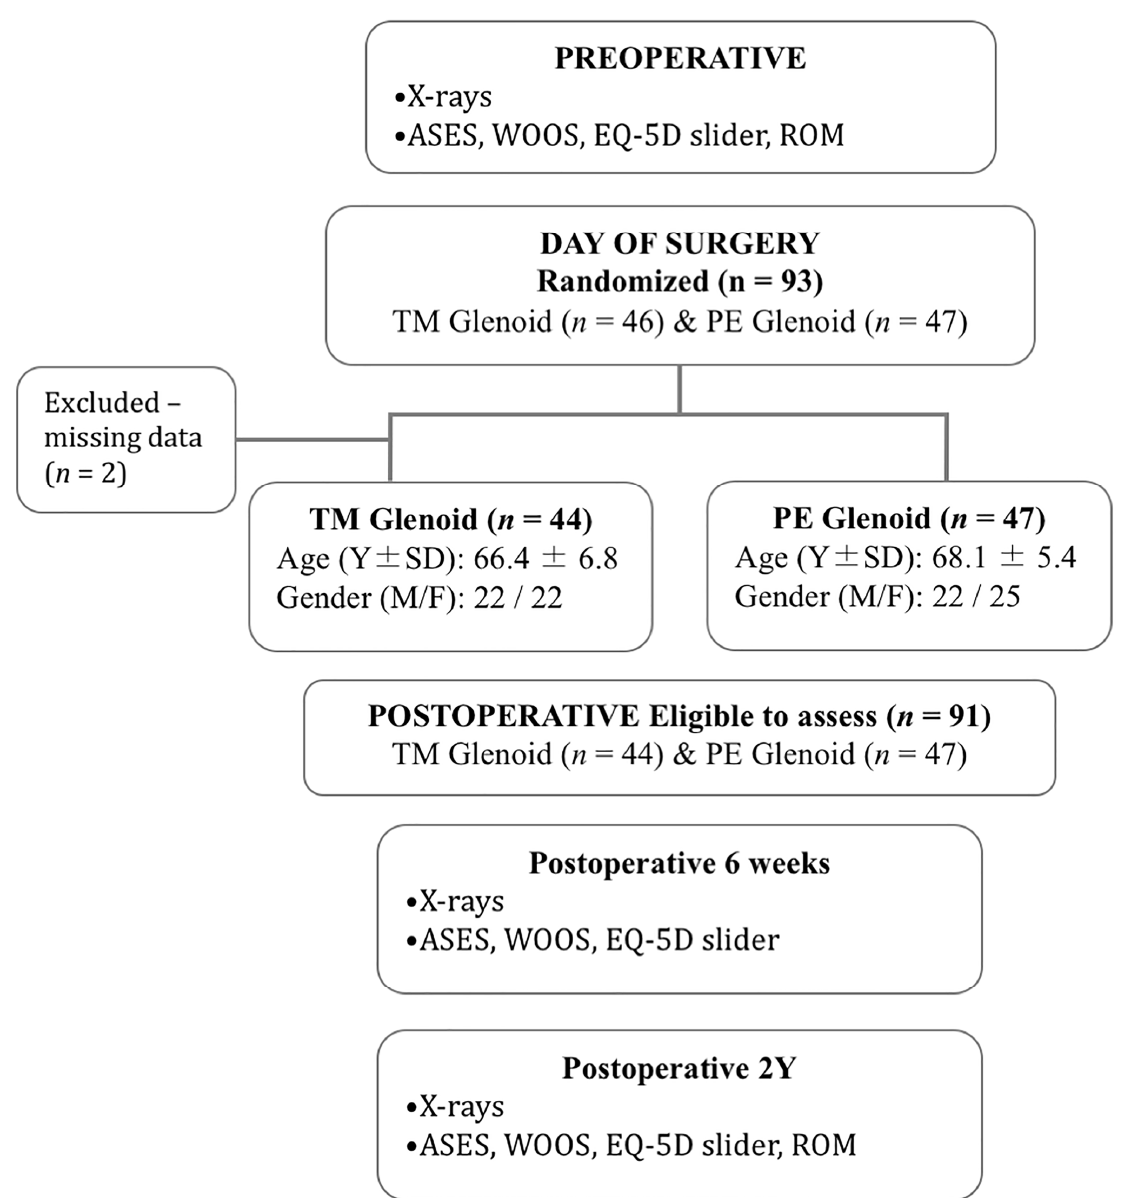
Figure 3. Consort Flow Diagram. American Shoulder and Elbow Surgeon (ASES) score [17]; Western Ontario Osteoarthritis of the Shoulder (WOOS) Index [18], quality of life scores, and EQ-5D health slider (0 = worst imaginable health status and 100 = best imaginable health status)